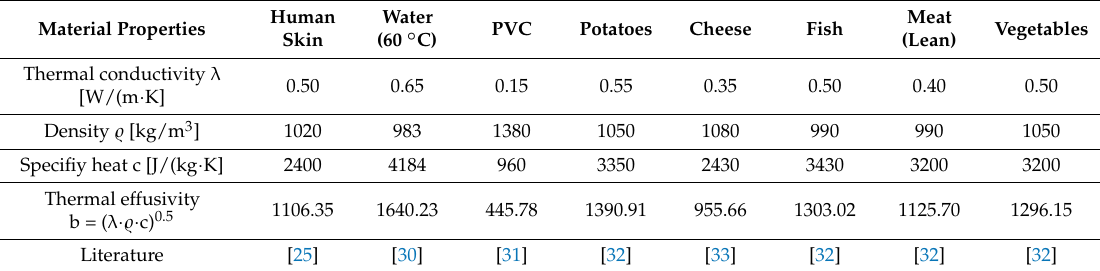
Table 2. Material properties